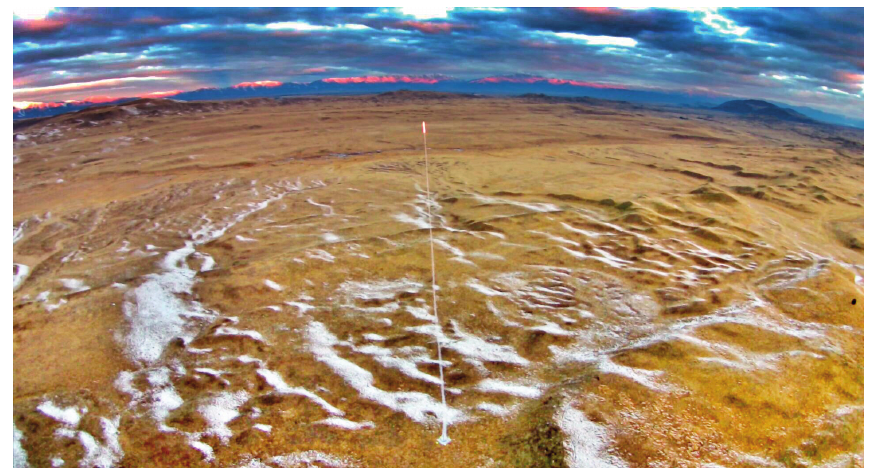
Figure 14. Still photo of Milly from unmanned aerial vehicle (UAV) video